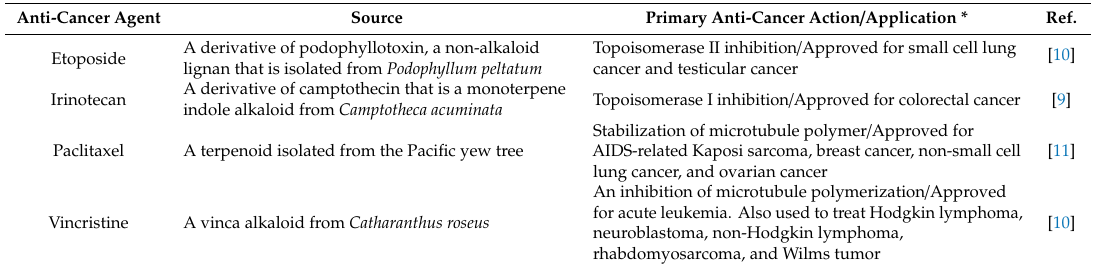
Table 2. Anti-cancer compounds derived from plants that are currently used in clinical practice.